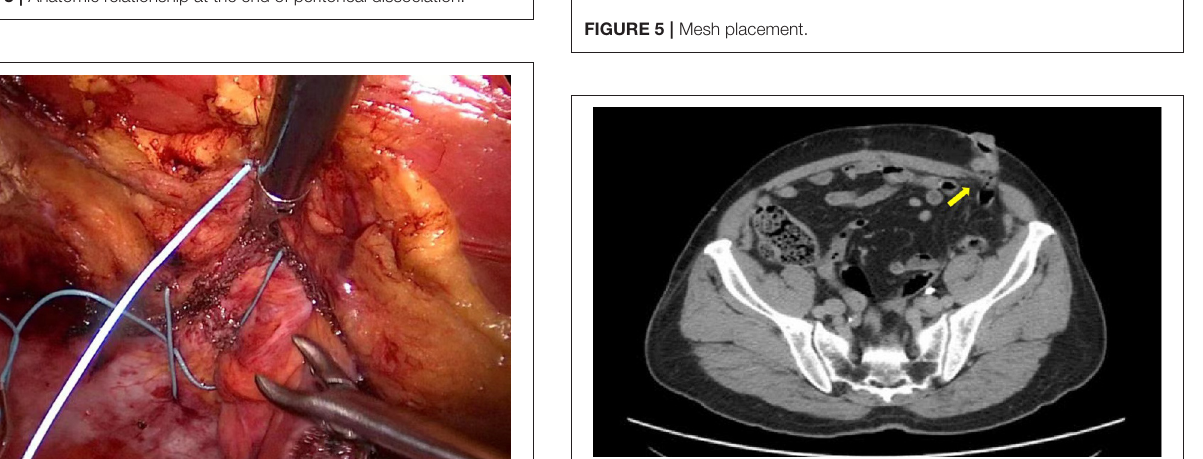
FIGURE 4 | Intraoperative picture of hernia ring closure.